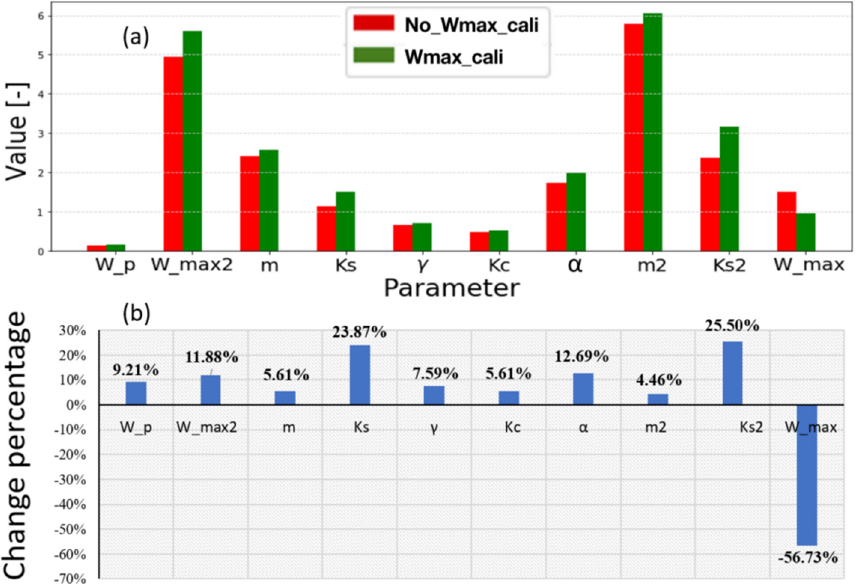
Figure 3. Influence on other parameters by the inclusion of calibration of W_max: ( a ) absolute change (note that W_max2 and W_max were scaled with 0.01 for plotting), and ( b ) change percentage.